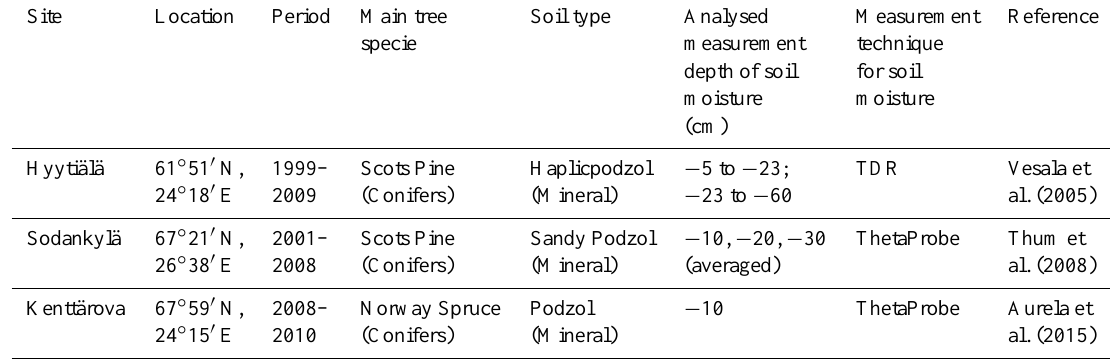
Table 1. Characteristics of the three micrometeorological sites. The plant functional types and the soil types in the JSBACH site simulations corresponding to observed tree species and soil types at the three sites are shown in